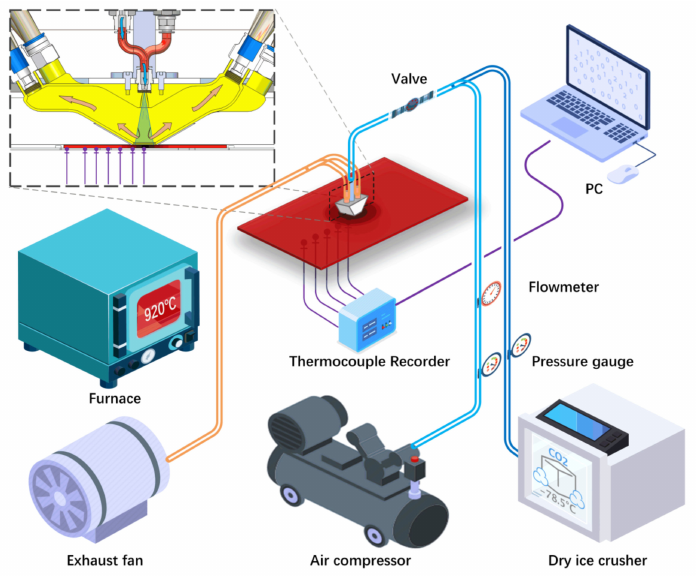
Figure 10. Diagram of the single-nozzle cooling experiment